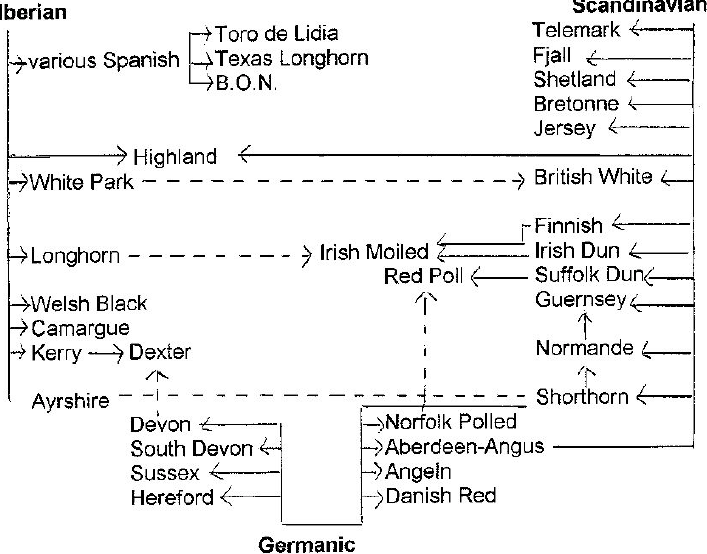
Figure 5. The three branches of Alderson [53]. Broken lines indicate slight or possible